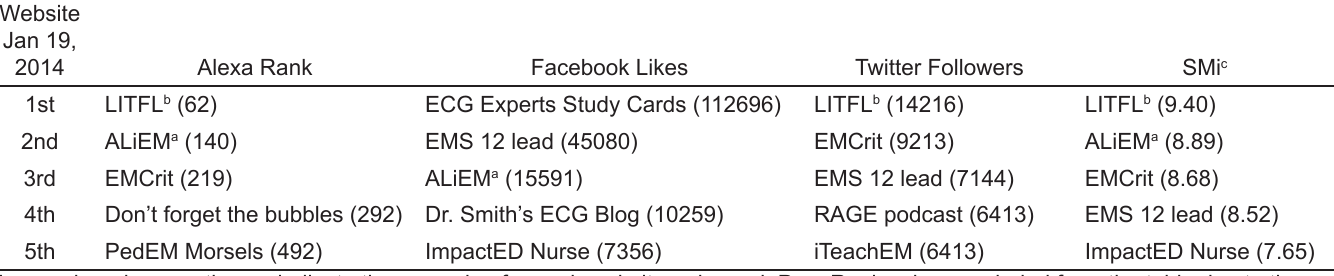
The numbers in parentheses indicate the raw value for each website or journal. PageRank values excluded from the table due to ties (only integer values from 0 to 10 are available). a ALiEM, Academic Life in Emergency Medicine